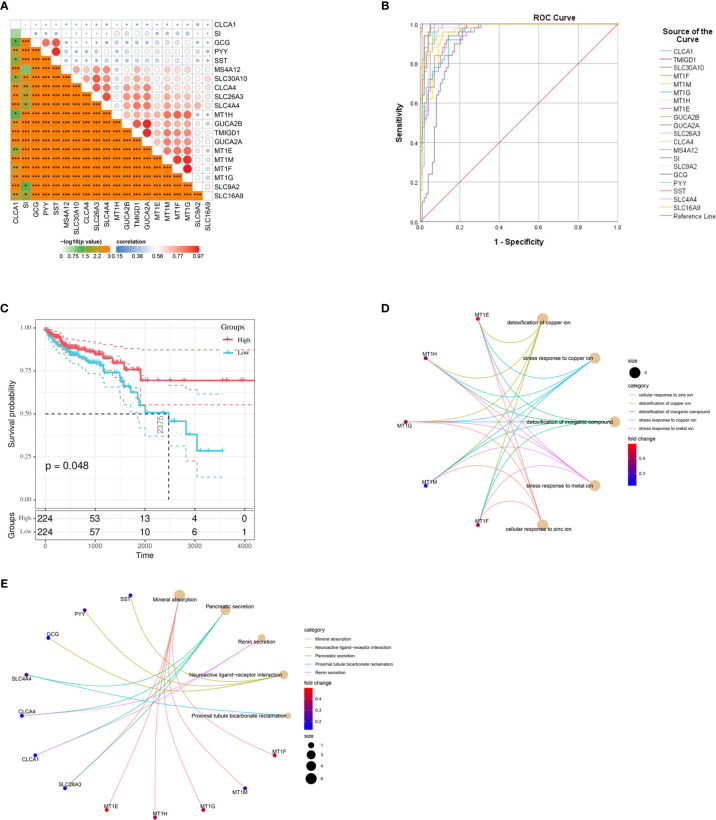
Different values of hub genes and ROC curves of the diagnostic model. (A) Hub genes show strong associations with each other. (B) ROC curves for the hub genes. (C) K-M plot for CLCA1. (D) Circo plot depicting the relationships between the hub genes and gene ontology (GO) terms. (E) Circo plots depicting the functions of the hub genes in Kyoto Encyclopedia of Genes and Genomes (KEGG) pathways. K-M, Kaplan-Meier.